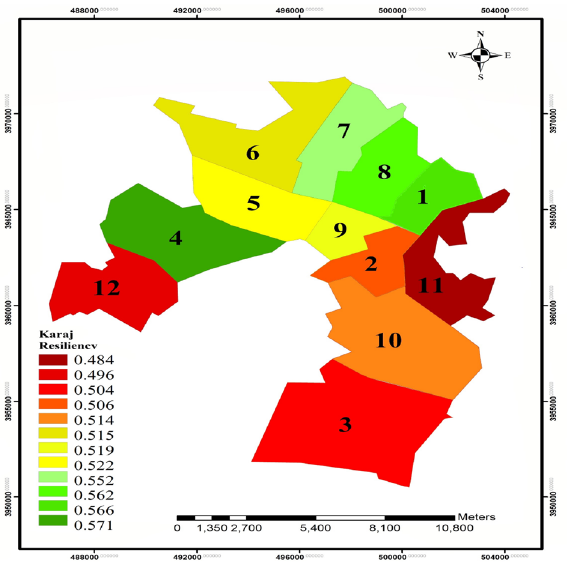
Figure 4. FR zoning in Karaj City (this figure was created in the Quantum GIS, version 3.12.2).